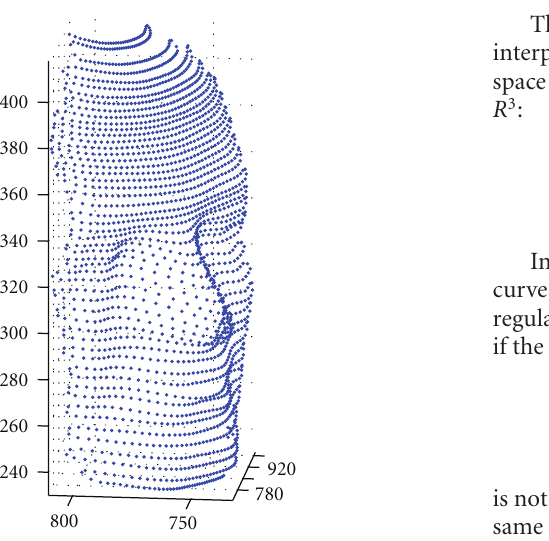
Figure 8: Portion of cloud of